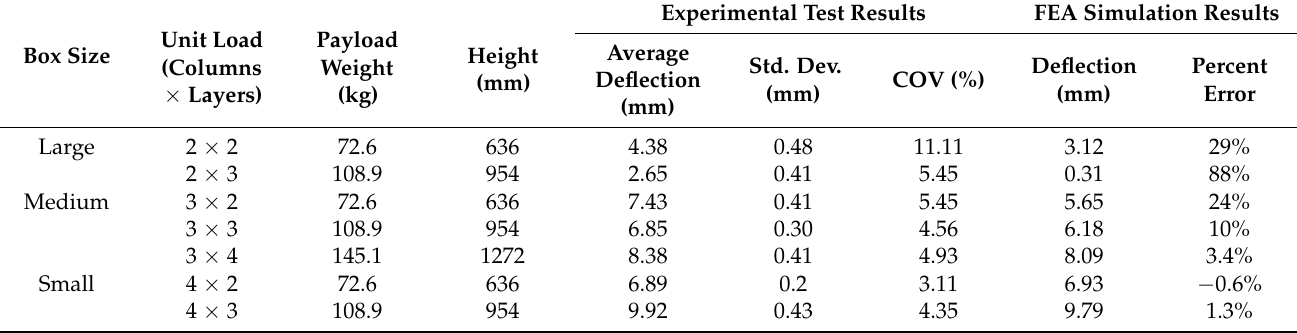
Table 9. Physical properties of each experimental unit with its corresponding deflection (mm) result for the experi- mental measurement and the finite element model simulation deflection result (mm) for each source of friction and its corresponding